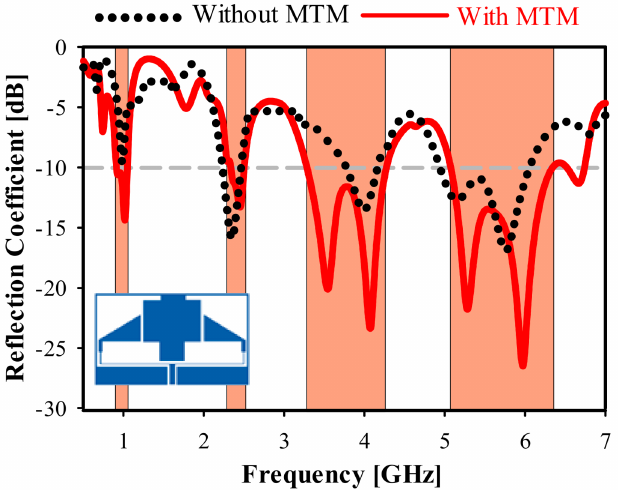
Figure 12. Simulated reflection coe ffi cient (S11) with and without